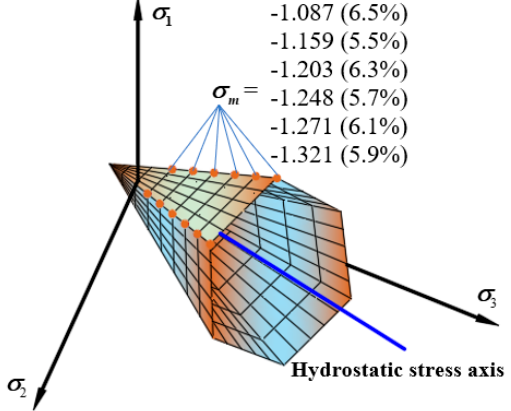
Figure 9. Linear failure envelope in π plane under different oil-stone ratios.